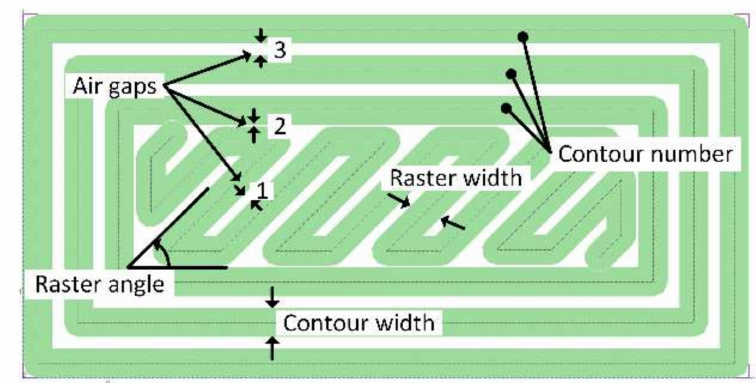
Figure 2. FDM process parameters.